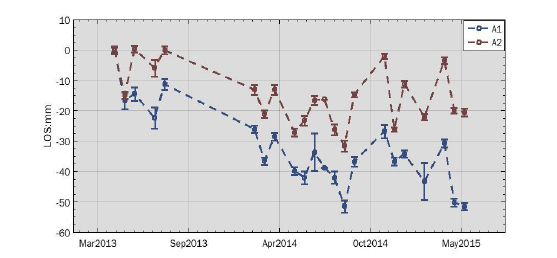
Figure 9. Change of water level in funnel